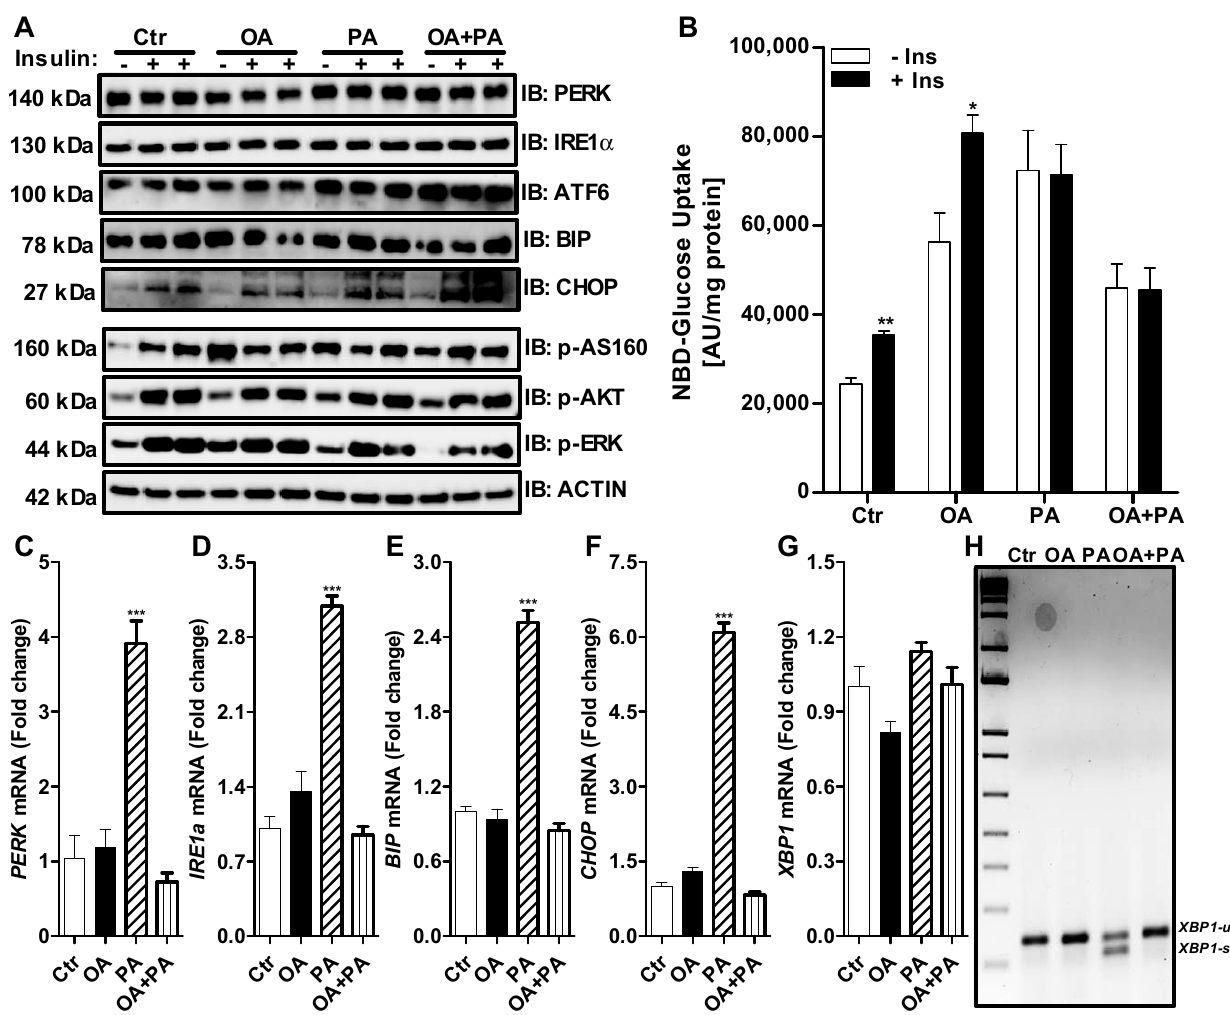
Figure 4. Oleate prevents palmitate induced alteration in ER stress but not ERK phosphorylation in Huh-7 cells. Huh-7 cells were treated without (Ctr) or with 0.2 mM of oleate (OA), palmitate (PA) or a combination of both (OA+PA) for 16 h prior to a 15 min challenge with 250 nM of bovine insulin. Cells were used to measure the expression of different ER stress and downstream insulin signaling pathway proteins by Western blotting (Panel A ). In a separate experiment, cells were used to determine the uptake of 2-NBD glucose for 1 h in triplicate after the insulin challenge (Panel B ). Cells were also used for the extraction of total RNA to measure the expression of various ER stress genes by qRT-PCR (Panels C – G ). Unspliced (u) and spliced (s) forms of XBP1 mRNA were measured by RT-PCR (Panel H ). Values were plotted as mean ± SD. p values were calculated using Student’s t test. *, p < 0.05; **, p < 0.01; ***, p < 0.001.